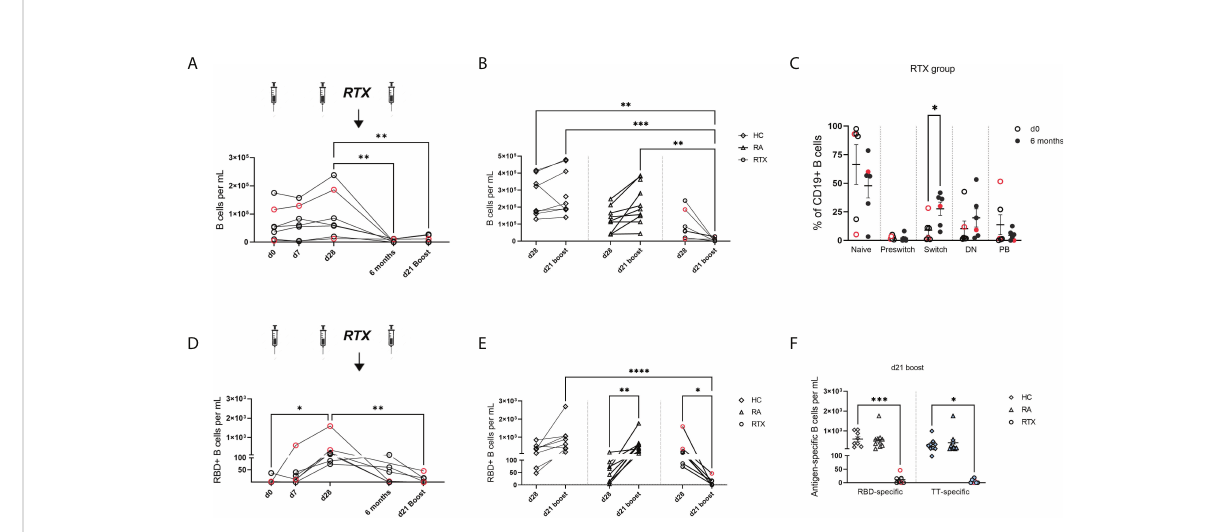
FIGURE 3 Trajectory of total B cells and antigen-speci fi c B cells upon SARS-CoV-2 vaccination in RTX treated patients. (A) Total B cell counts over time in the RTX group (n=7). (B) Comparison of total B cell numbers between HC (n=10), RA (n=10) and RTX (n=7) at d28 and d21 boost. (C) B cell subset distribution at d0 and 6 months (before 3 rd vaccination) in the RTX group (n=7). (D) Absolute numbers of RBD+ B cells over time in the RTX group (n=7). (E) Absolute numbers of RBD+ cells at d28 compared with d21 boost in HC (n=10), RA (n=10) and RTX (n=7). (F) Absolute numbers of RBD+ B cells at d21 boost compared with TT+ B cells in HC, RA and RTX. Friedman test with Dunn´s post-test. (A, D) . Kruskal- Wallis with Dunn´s post-test (B, E, F) . Mann Whitney test for each subset performed (C) . *p < 0.05, **p < 0.01, ***p < 0.001, ****p < 0.0001. Color code: previously infected individuals are indicated in red; control TT results are indicated by blue fi lled circles. DN, “ double negative ” CD27+IgD- B cells; PB,